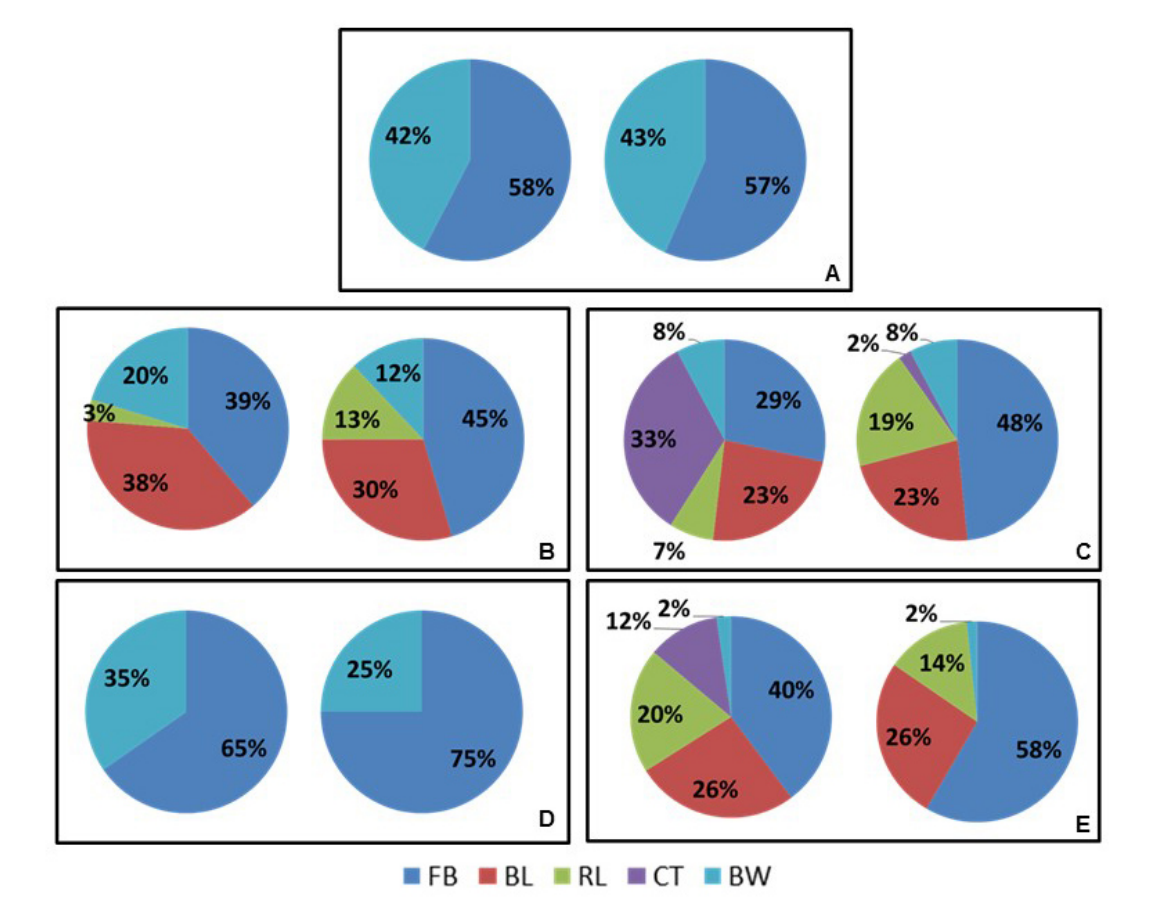
Figure 12. Relative quantification of the defect site of all groups 30 and 60 days after procedure observed in histological sections. (A) Group 1; (B) Group 2; (C) Groups 3; (D) Group 4; (E) Group 5. FB: newly formed bone; BL: calcium phosphate material; RL: resorption lacunae; BW: bone marrow; CT: cellularized connective tissue.